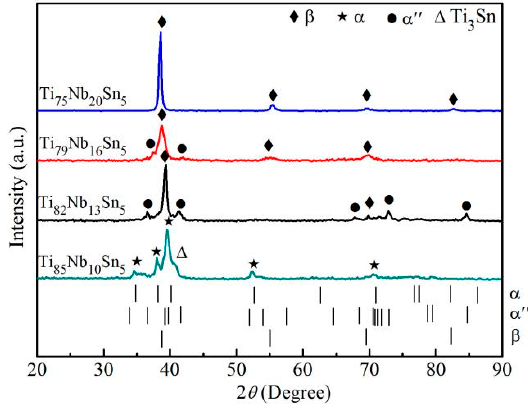
Figure 1. XRD patters of Ti 85- x Nb 10+ x Sn 5 ( x = 0, 3, 6, and 10 at.%) alloys.